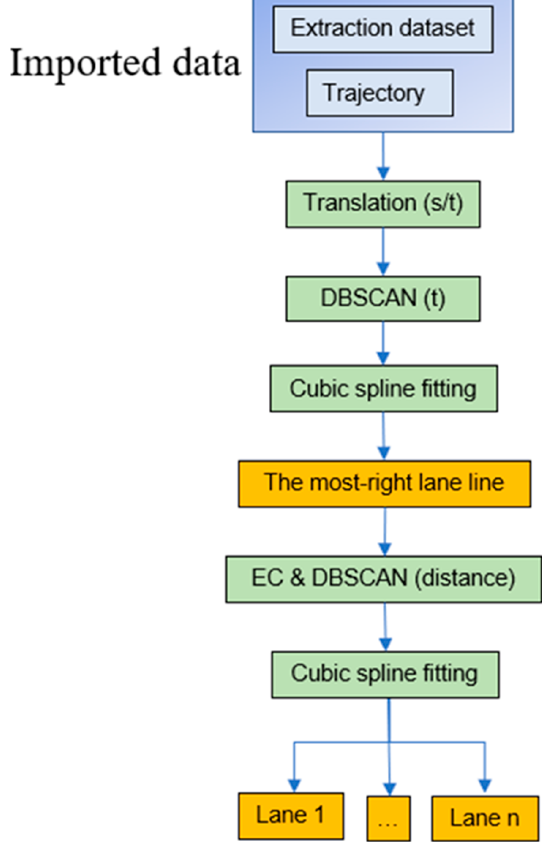
Figure 5. Flowchart of the classification